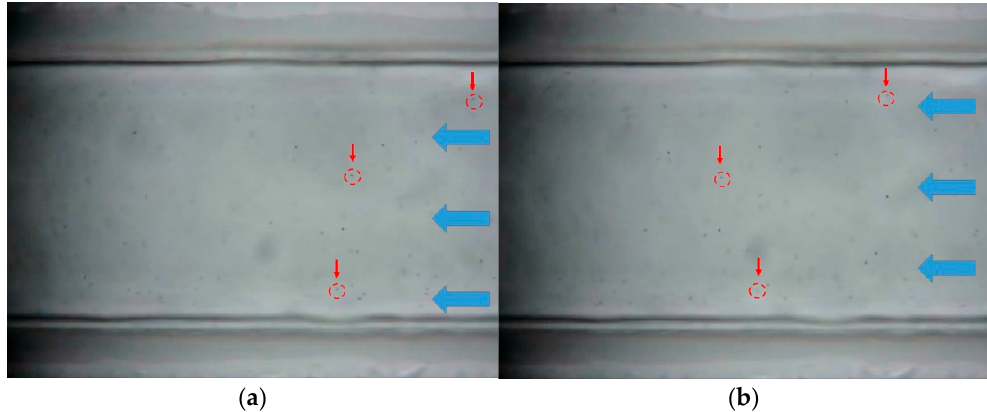
Figure 5. Experimental results of flow characteristics of copper contaminants–capillary tube bottom: ( a ) particle position before moving; ( b ) particle position after